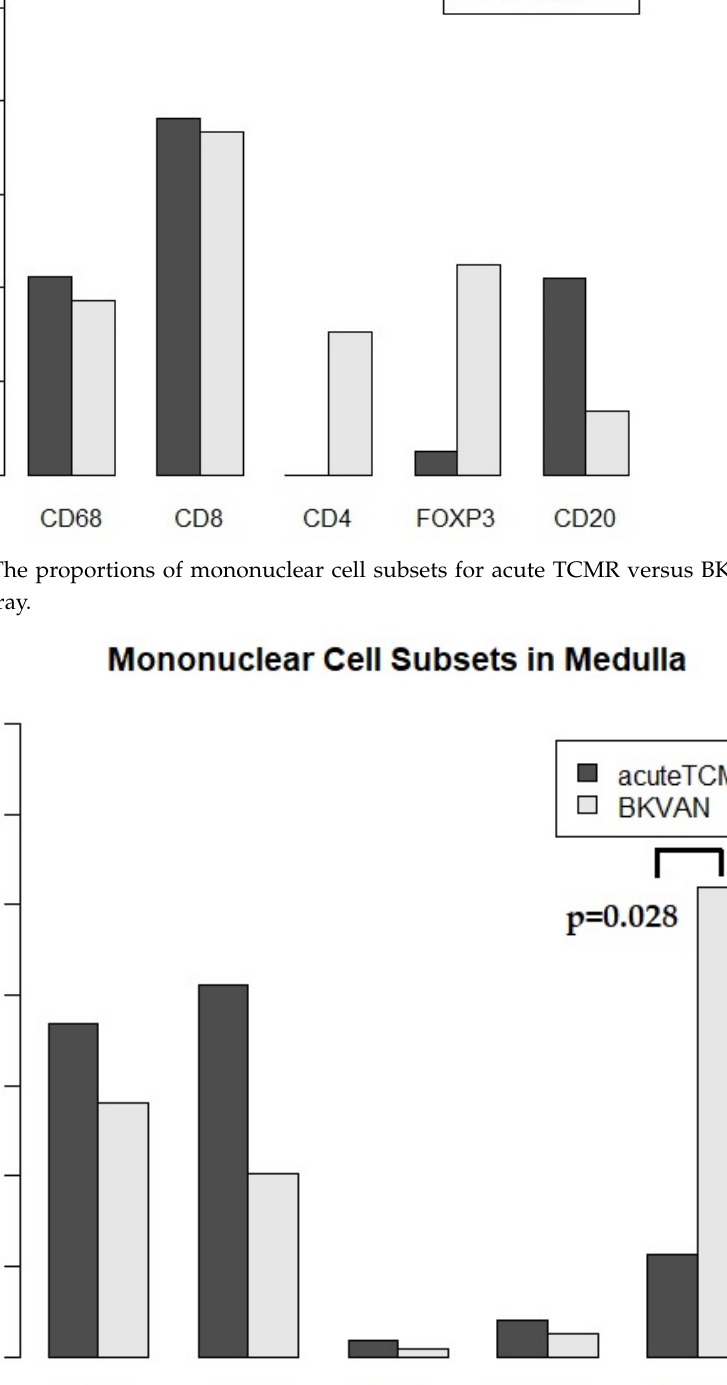
Figure 6. The proportions of mononuclear cell subsets for acute TCMR versus BKVAN cases in medulla. CD20+ cells were significantly more prevalent in BKVAN than TCMR cases ( p = 0.028).